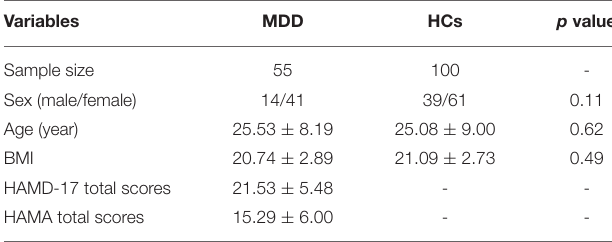
TABLE 1 | Demographic and clinical characteristics of